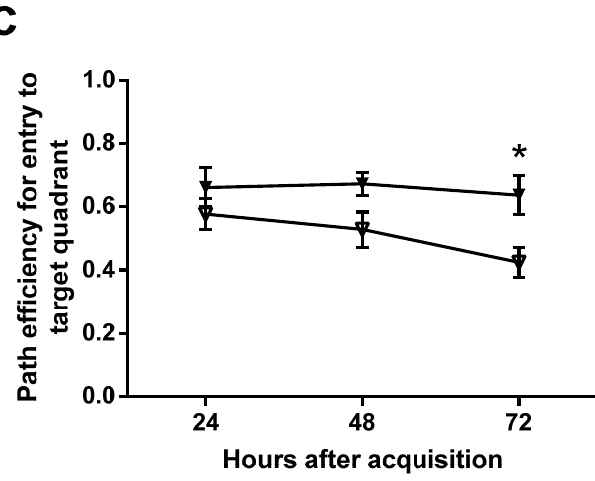
Figure 4. MWM performance in testing trials evaluated at 24, 48, and 72 h after the acquisition tests. The memory retention was analyzed using the latency to ( A ) and the path efficacy to the targeted quadrant ( B ) the targeted quadrant and the initial heading error from the platform zoon ( C ). The data are presented as mean ± SEM, n = 16, BG = blank gel, * p < 0.05, ** p < 0.01.